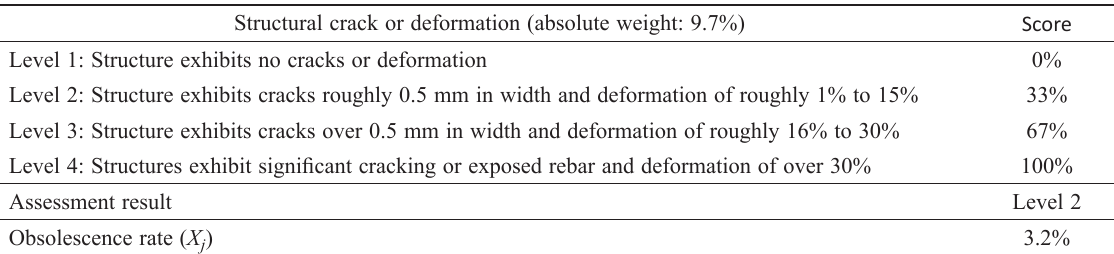
Table 3. Calculating the degree of obsolescence for structural crack or deformation Structural crack or deformation (absolute weight: 9.7%)